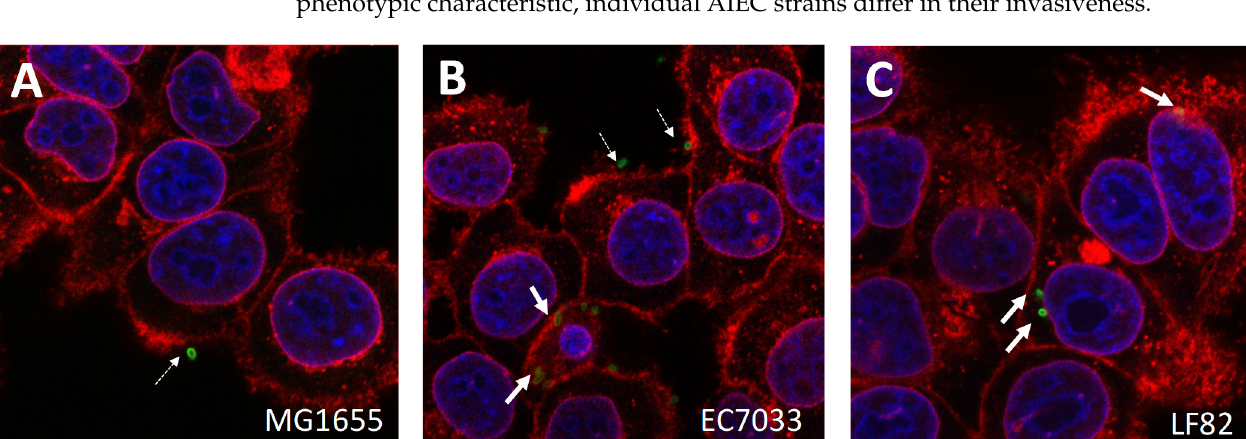
Figure 5. Confocal microscopy illustrating the rare events of cell-adhering (extracellular) and cell-invaded (intracellular) E. coli strains on I-407 cells after a 3 h incubation and extensive washings. ( A ): Non-invasive MG1655 ( B ): EC.7033 AIEC. ( C ): LF82 AIEC. Extracellular (dotted arrows) and intracellular (bold arrows) bacteria are identified by immune detection (green); Epithelial cells are contrasted by DAPI-labelled nuclei (blue) and WGA-labelled membranes (red) (see methods). Original magnification × 63.